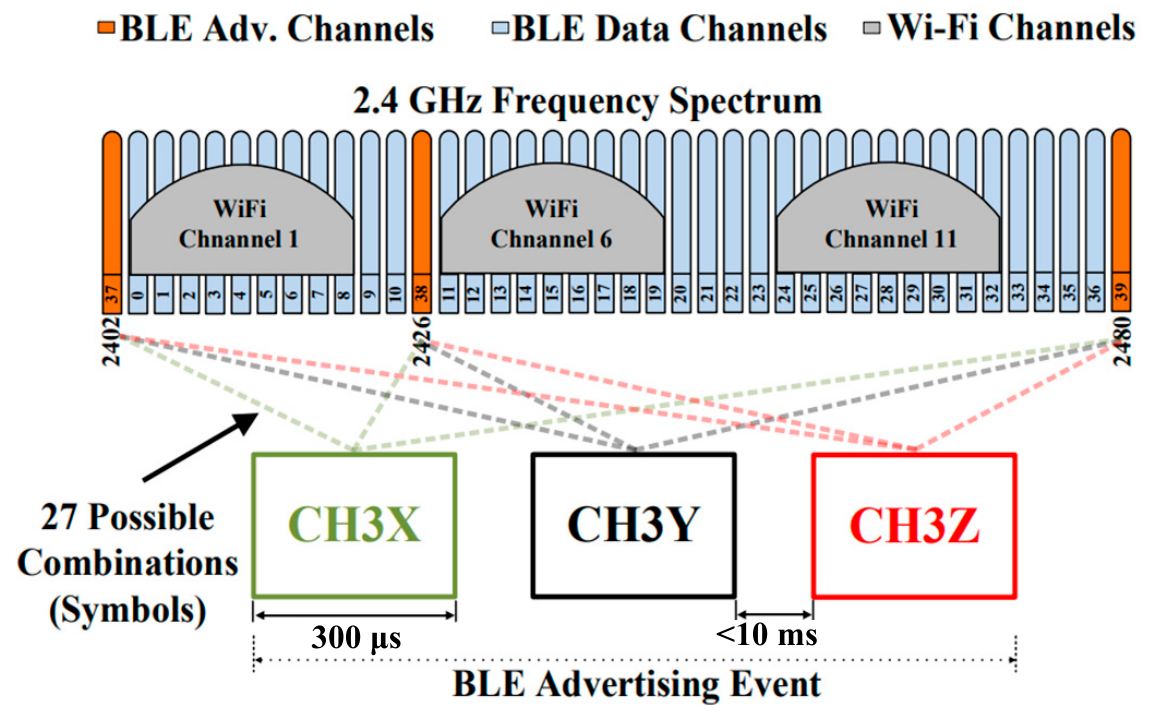
Figure 5. Structure of a BLE advertising event.